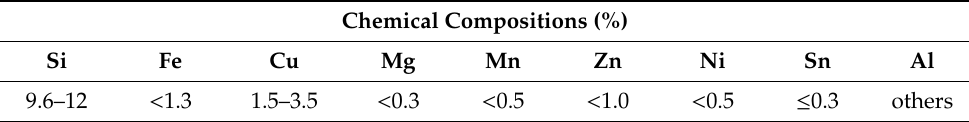
Table 1. compositions of the ADC12 aluminum